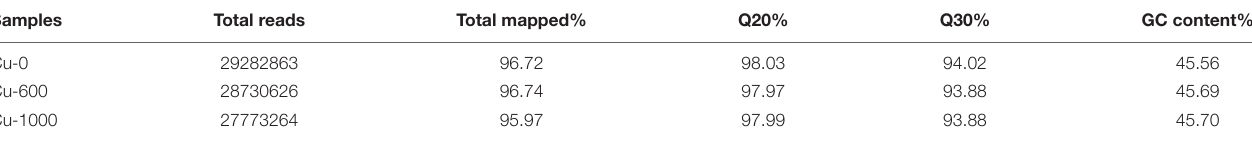
TABLE 3 | Statistical analysis of transcriptome sequencing